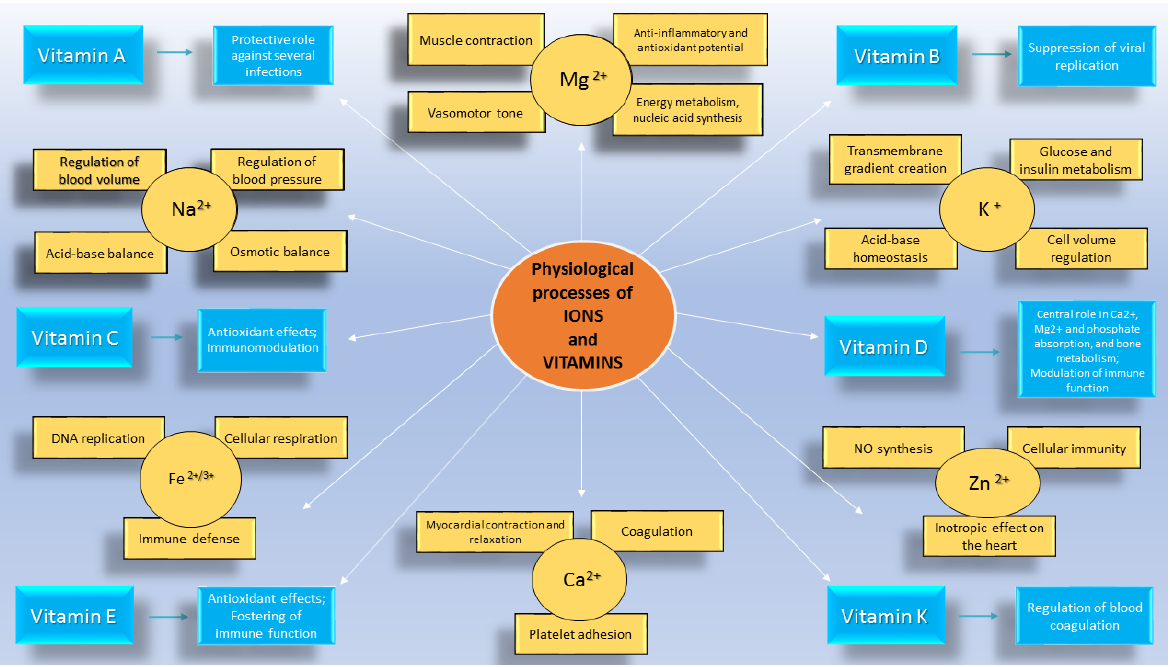
Figure 1. Micronutrients imbalance may contribute to cardiovascular complications observed dur- ing COVID-19. NO: nitric oxide; DNA: deoxyribonucleic acid; Mg 2+ : magnesium; K + : potassium; Zn 2+ : zinc; Ca 2+ : calcium; Fe 2+/3+ : iron; Na 2+ : sodium.